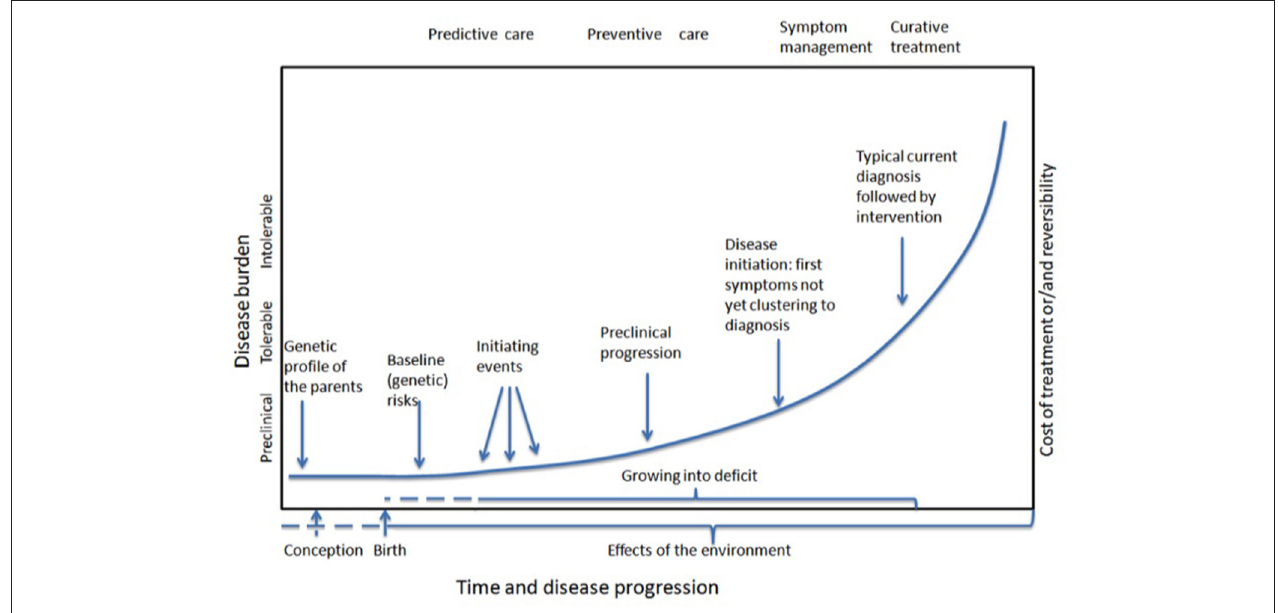
FIGURE 1 | Modification of Syurina’s adaptation of Snyderman’s curve representing the timelines of “growing into deficit” and developing common complex